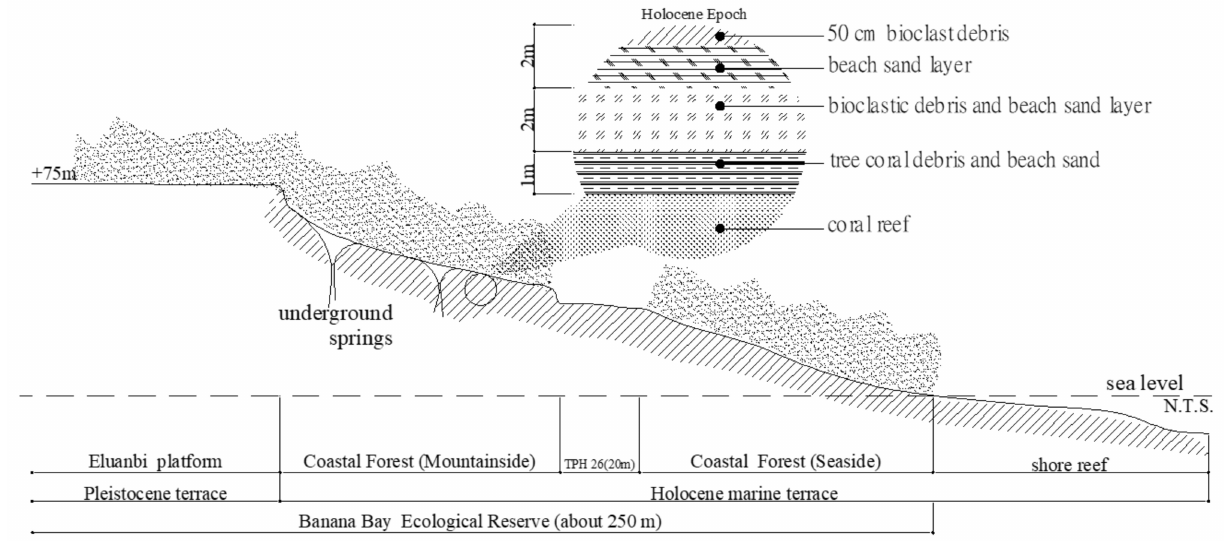
Figure 3. Topographic section of Banana Bay terrace. (Note: data from